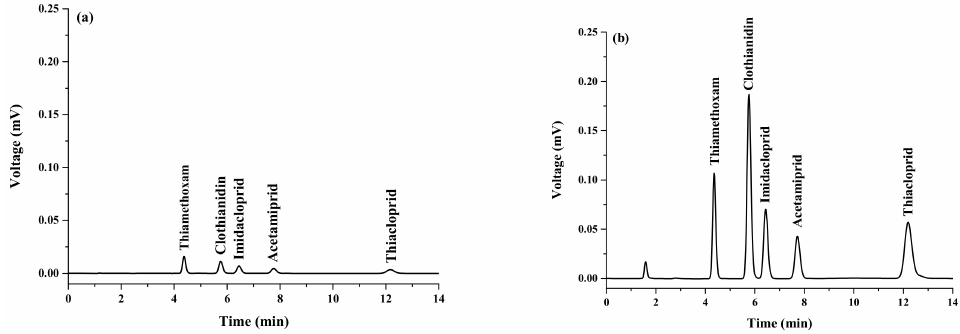
Figure 6. Chromatograms of standard neonicotinoids obtained ( a ) without preconcentration, and ( b ) with preconcentration using the proposed method (concentration of all standards was 500 ng mL − 1 ).